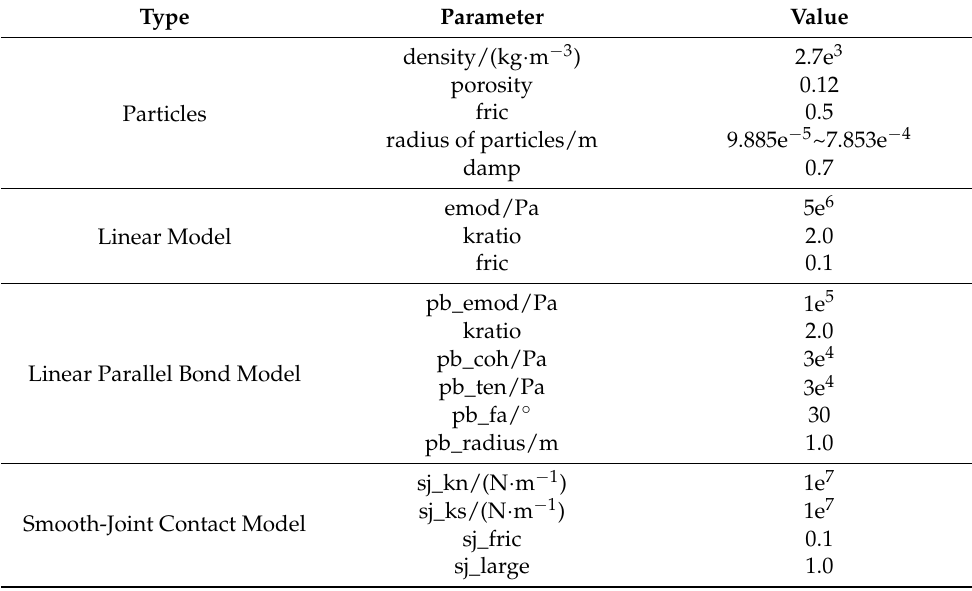
Table 5. Micro-mechanical parameters of numerical model.